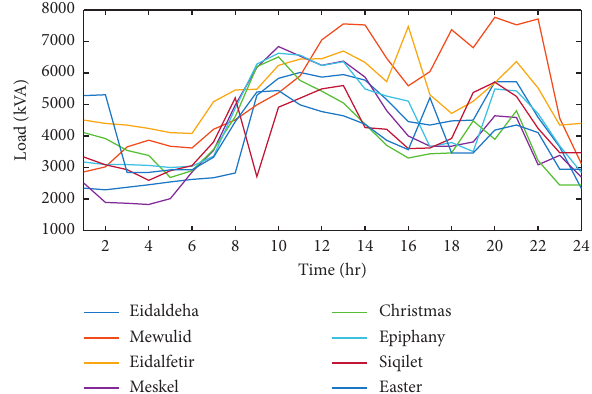
Figure 2: Hourly load profile of religious holidays in